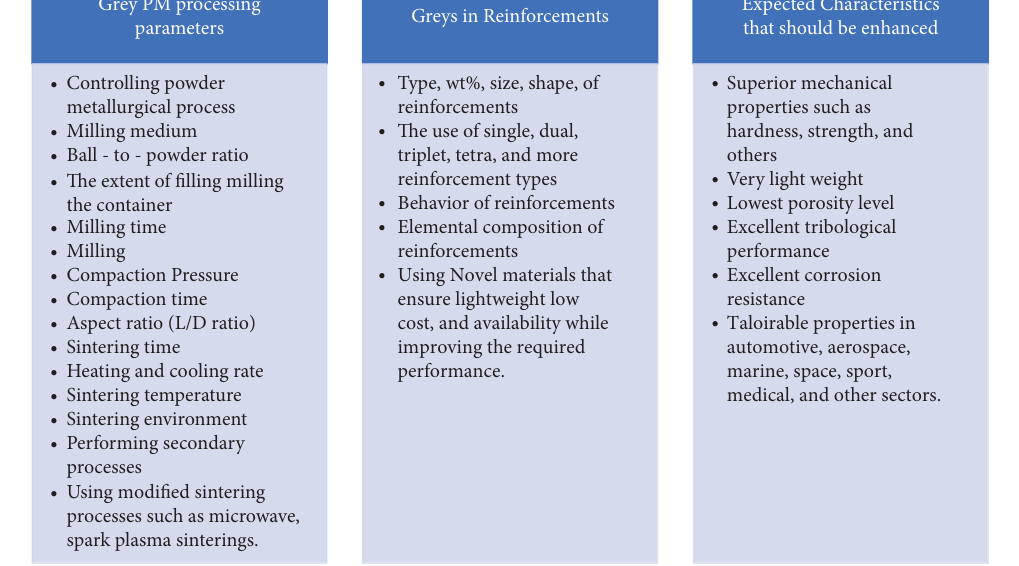
Figure 23: Grey research areas in AMC and HAMCs and PM process